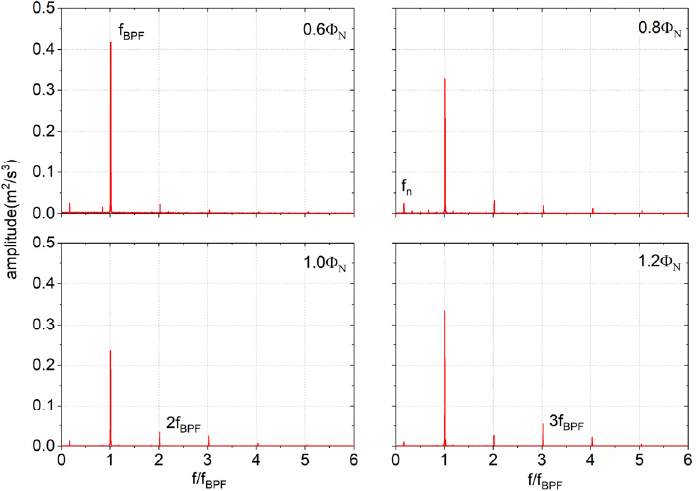
Figure 7. Velocity spectra at point I4 under four typical working conditions.